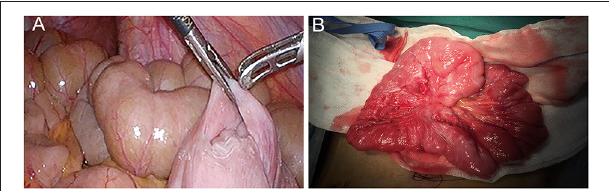
FIGURE 2 | (A) Antegrade intussusception was observed directly through laparoscopic operation. (B) An intraoperative incision was made after laparoscopy in order to ascertain that adhesion among focal walls is restored, and that the layer of injured bowel serosa would be sutured integrally.